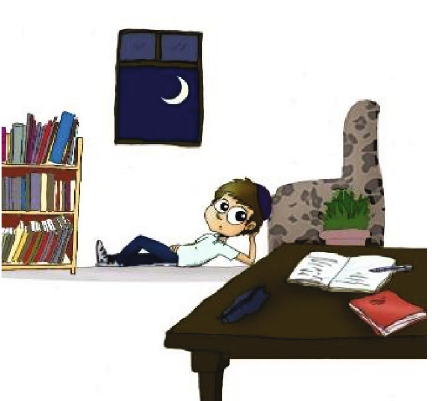
Figure 4: “ Daniel lies and dreams despite being repeatedly told to learn Torah.